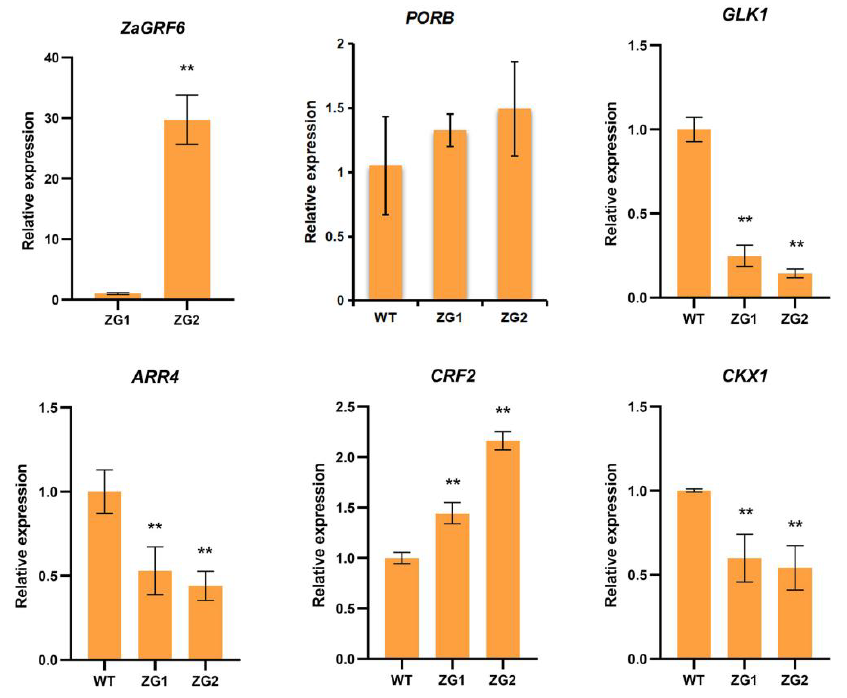
Figure 10. Expression levels of ZaGRF6 , PROB , GLK1 , ARR4 , CRF2 , and CKX1 in transgenic and wild-type plants. The error bars represent the standard error of the means of three independent replicates of qRT-PCR analysis. p values were determined according to one-factor ANOVA test (** p < 0.01) ( n = 3).